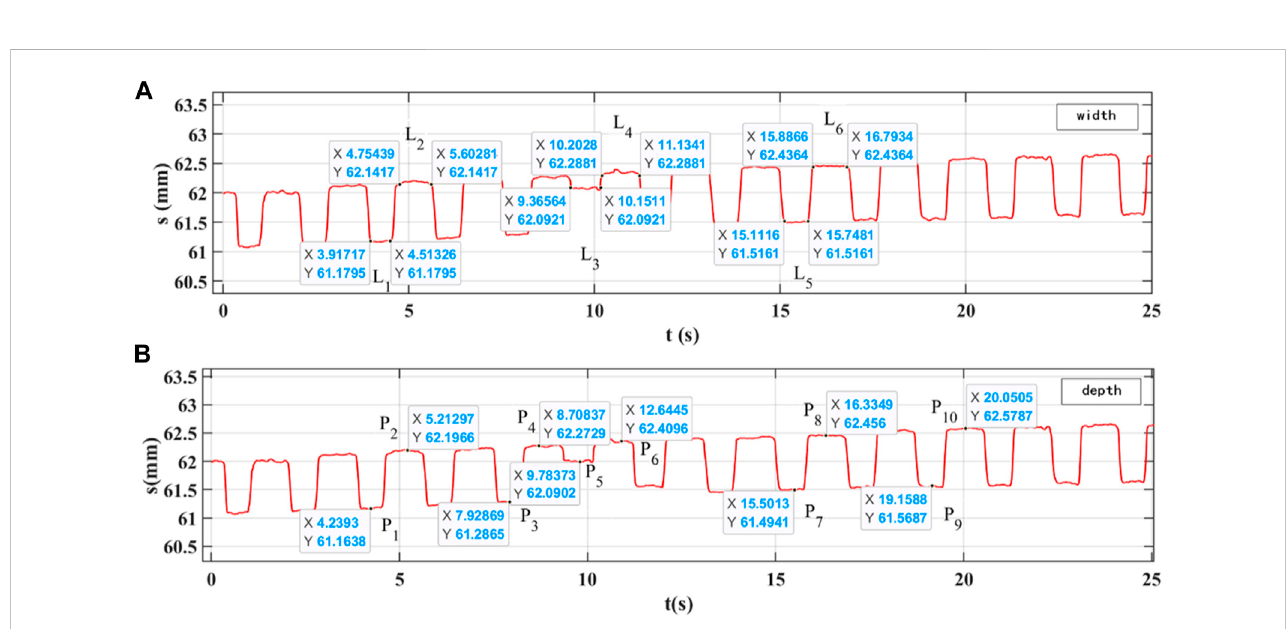
FIGURE 2 Barrel bore contour curve diagram. (A) Width of ri fl ing. (B) Depth of ri fl